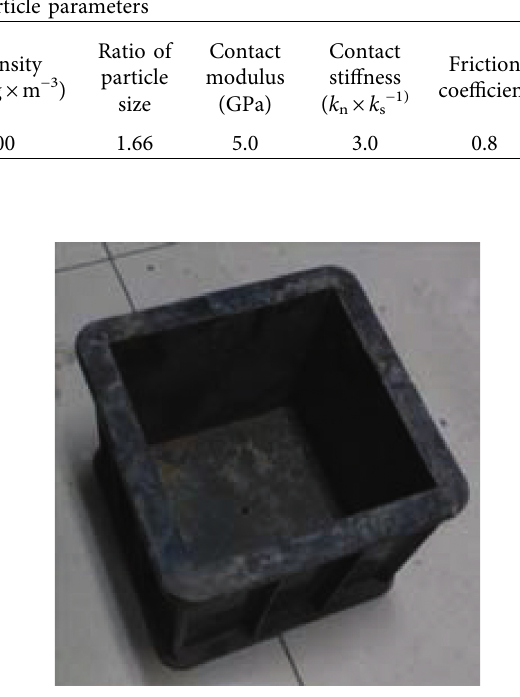
Figure 1: Similar model sample mold.